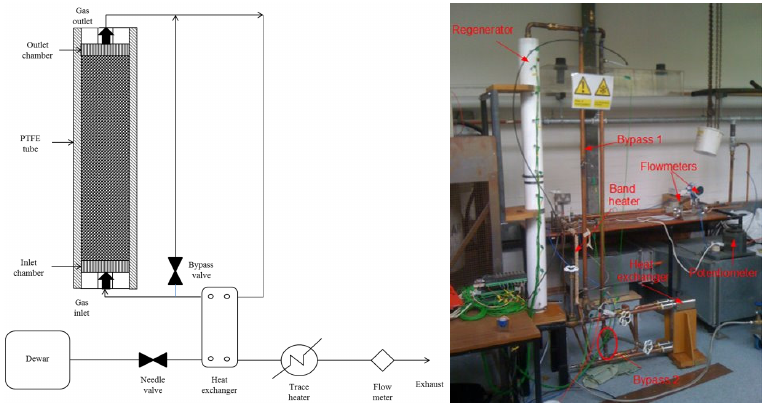
Figure 5. Schematic ( left ) of the lab-scale packed bed regenerator (PBR) as provided in [31] and photograph ( right ) without insulation.